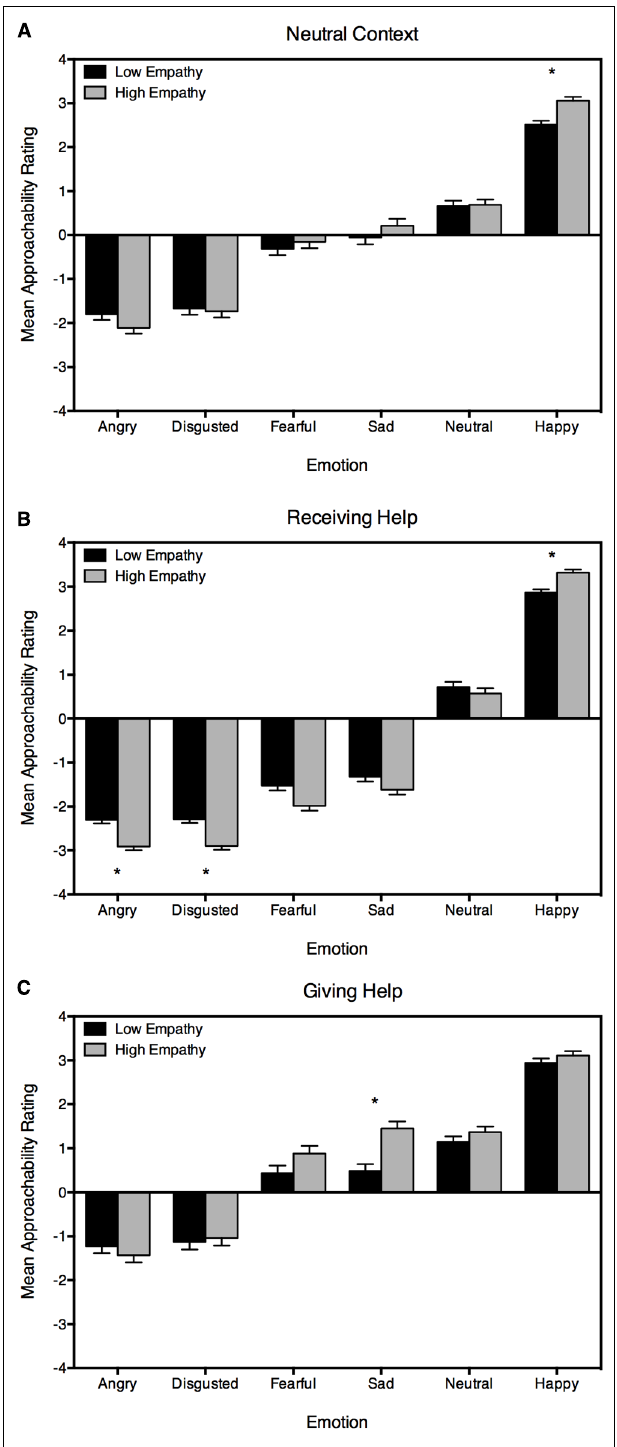
FIGURE 1 | Predicted approachability ratings for low and high empathy are displayed for each facial expression, separately for the three contexts: (A) neutral context, (B) receiving help, and (C) giving help. Low empathy is estimated based on one SD below the mean and high empathy on one SD above the mean. Standard error bars are shown. Asterisks are provided to identify those emotions for which empathy was a significant